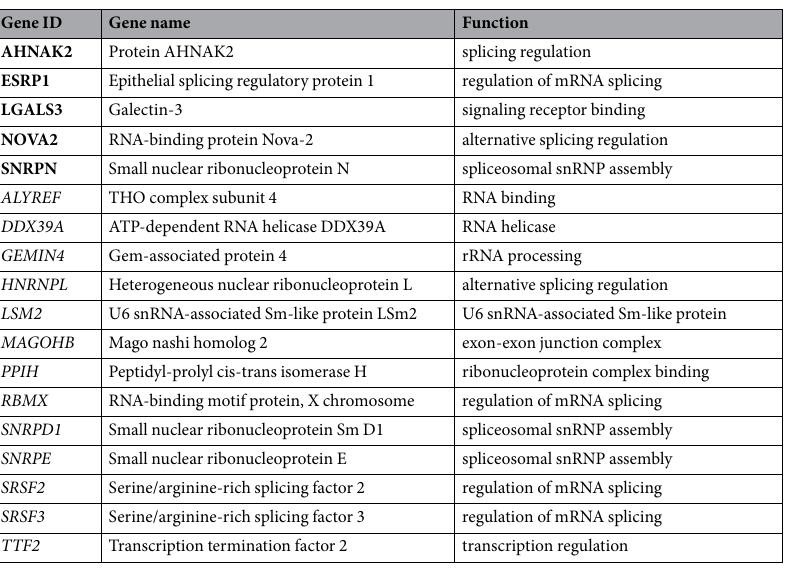
Table 2. Splicing regulators showing changes in expression 24 hours post-radiation. Factors showing an increase in the expression are shown in bold, while factors showing a decrease in the expression are represented in